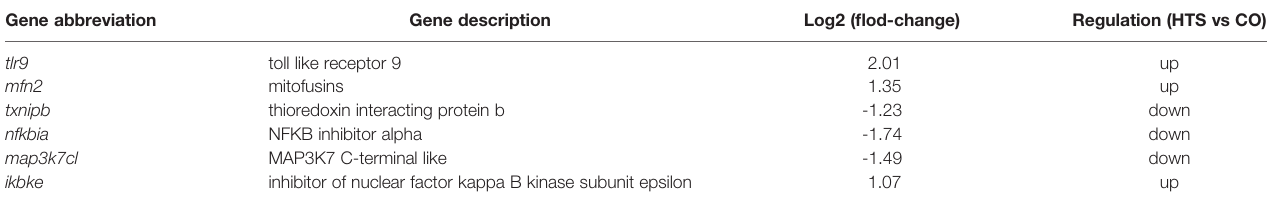
TABLE 3 | Differentially expressed mRNA veri fi ed by mRNA-Seq.